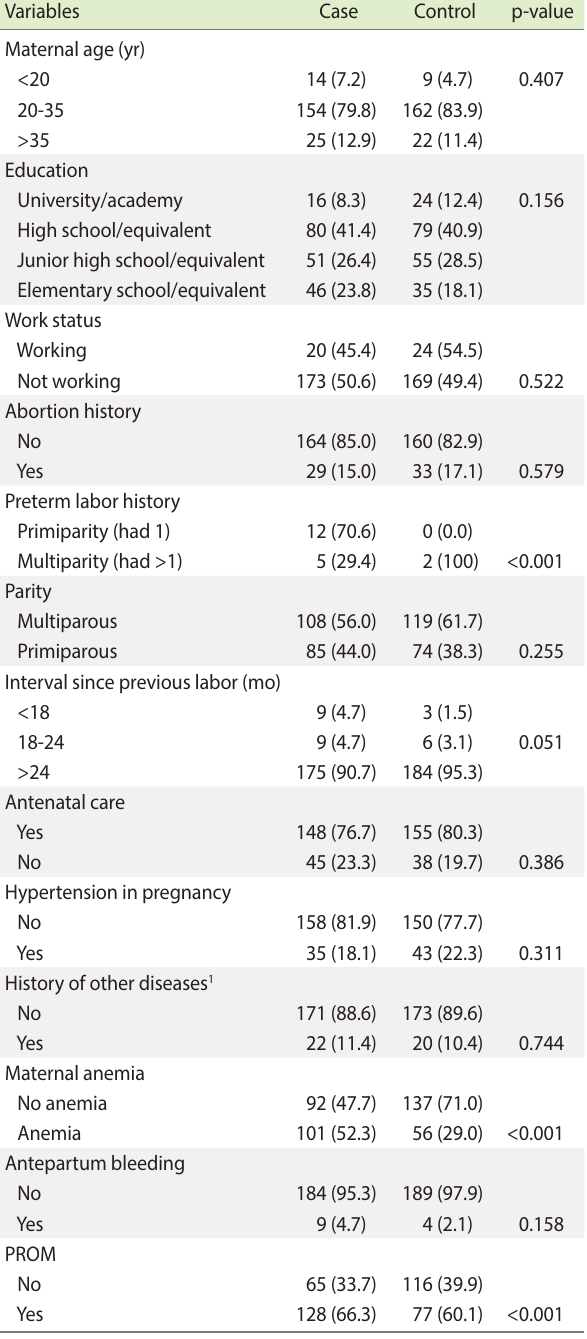
Table 1. Distribution of maternal characteristics, obstetric history, variables related to current pregnancy, and premature rupture of membranes (PROM) among cases and controls